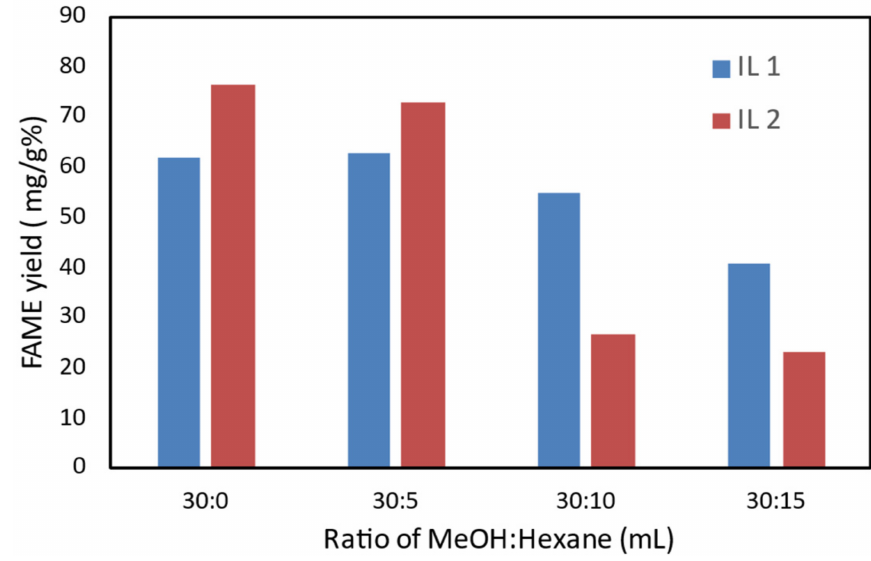
Figure 5. Effect of co-solvent on FAME yield. Table 1. FAME components found C. vulgaris